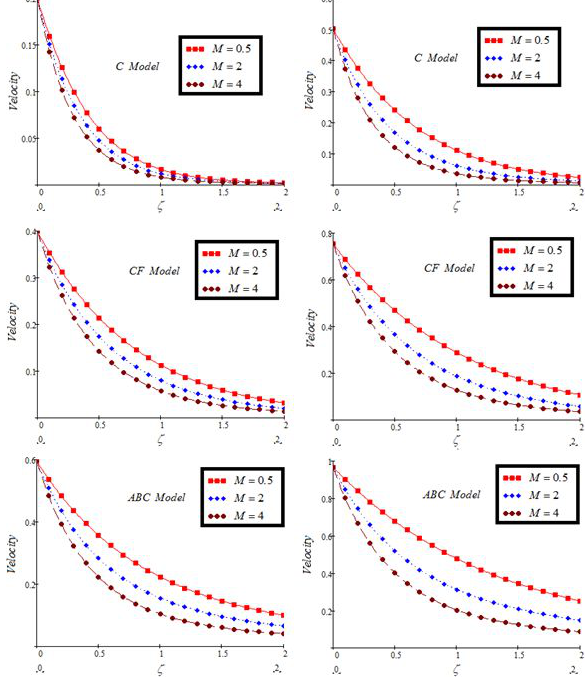
Figure 4: Velocity profile for FD’s with variation of M and Pr = 0.7, Gm = 2, ε =